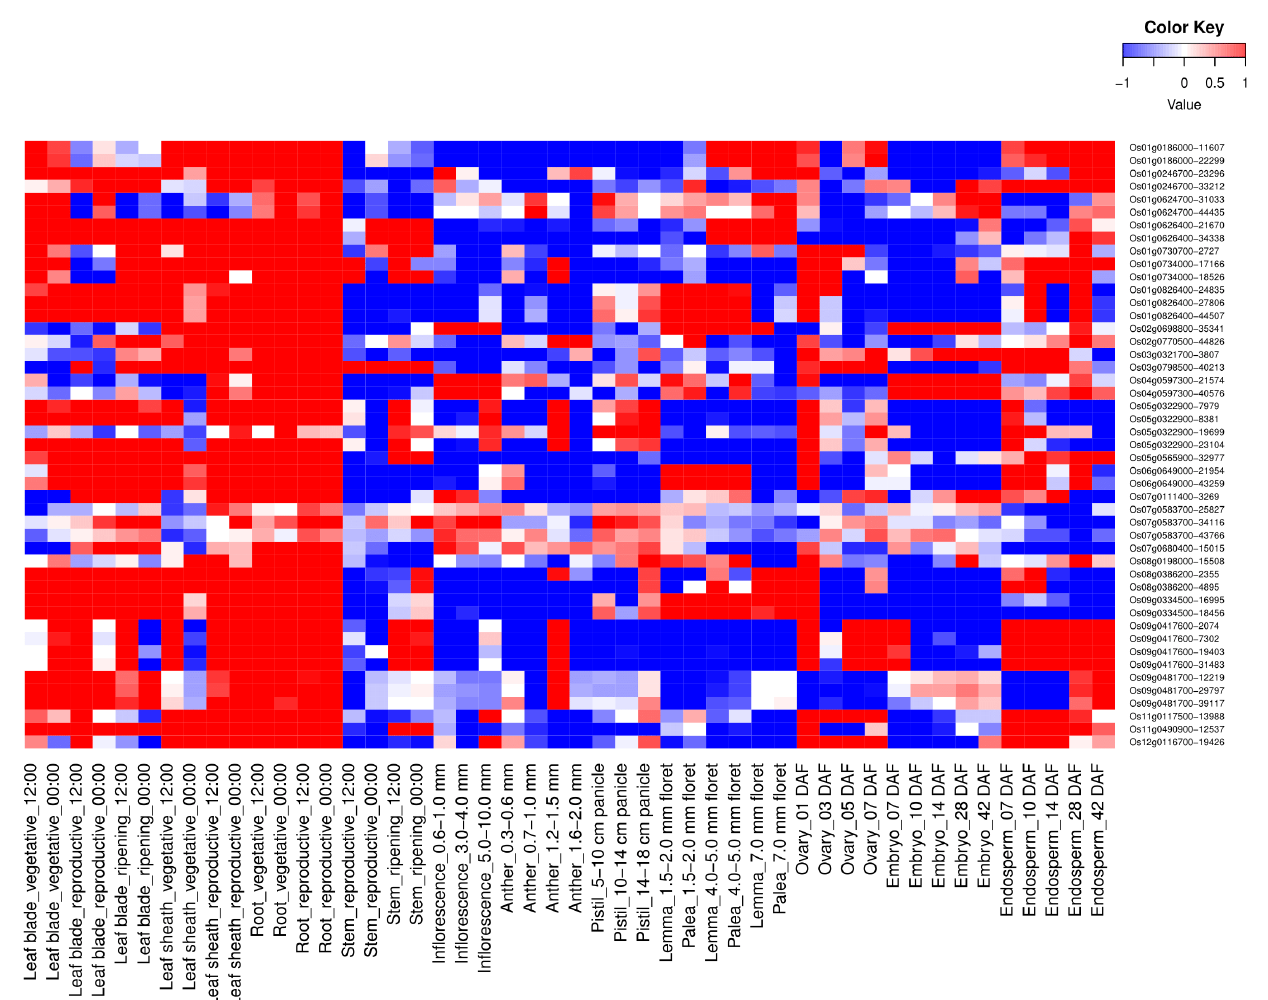
Figure 1. Heatmap of 26 potential OsWRKY TF family members showing the spatio-temporal gene expression profile of tissue/organ types at different developmental stages which are differentially expressed under natural field conditions. The red color indicates up-regulation, the blue color indicates down-regulation, and the white color indicates no expression. The color bar at the right side top represents the level of expression value, where − 1 and 1 represent the down- and up-regulation of AbS responsible OsWRKY TF family